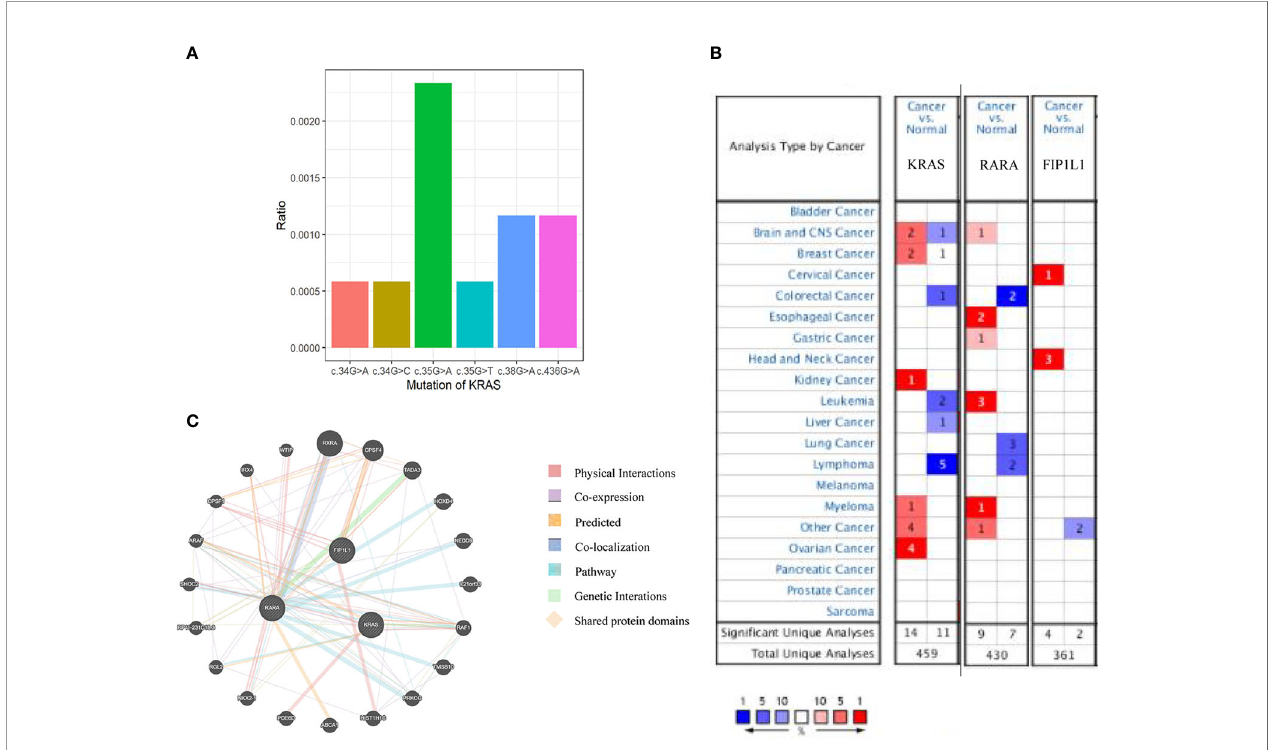
FIGURE 2 | Bioinformatic analyses of KRAS , RARA , and FIP1L1 genes. (A) An overview of the mutations in KRAS in the samples from patients with hematopoietic malignancies, according to the COSMIC database. (B) The number of datasets that had mRNA overexpression (red) or down-regulated expression (blue) of the KRAS , RARA , and FIP1L1 gene in ONCOMINE. The threshold was designed with the following parameters: p-value of 1E − 4 and fold change of 2. (C) Network of KRAS , RARA , and FIP1L1 and their 20 related genes was analyzed by